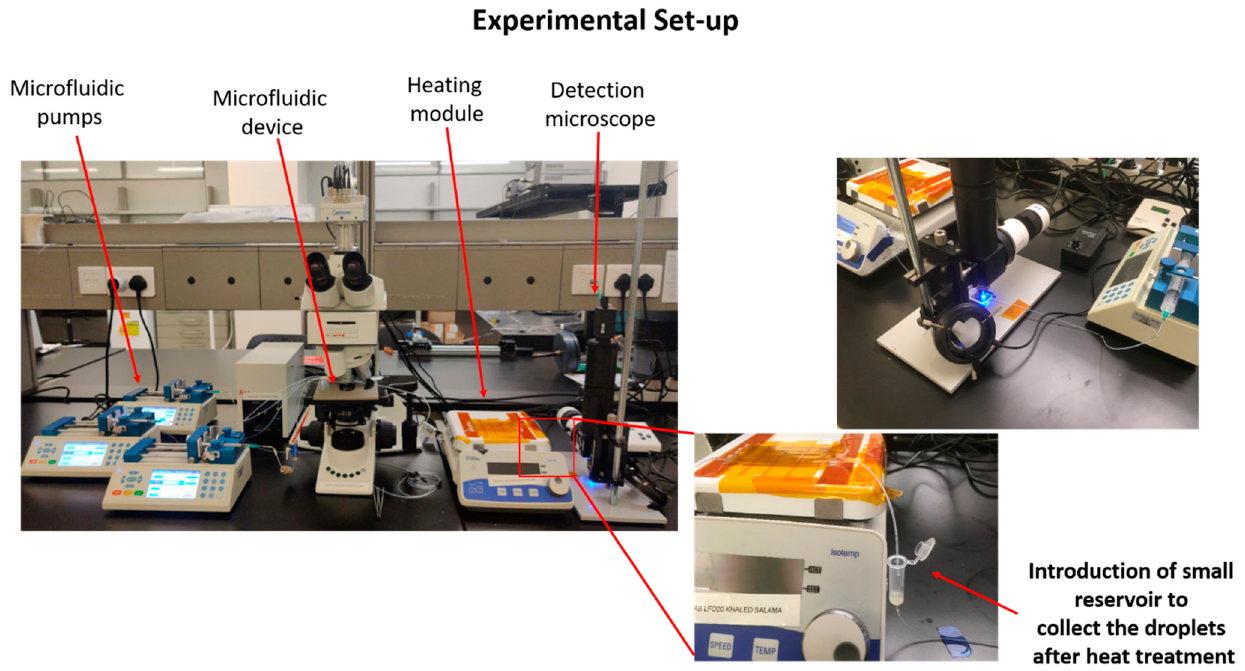
Figure A1. Photograph of the scheme of the microfluidic set-up for the isolation and detection of E. coli .